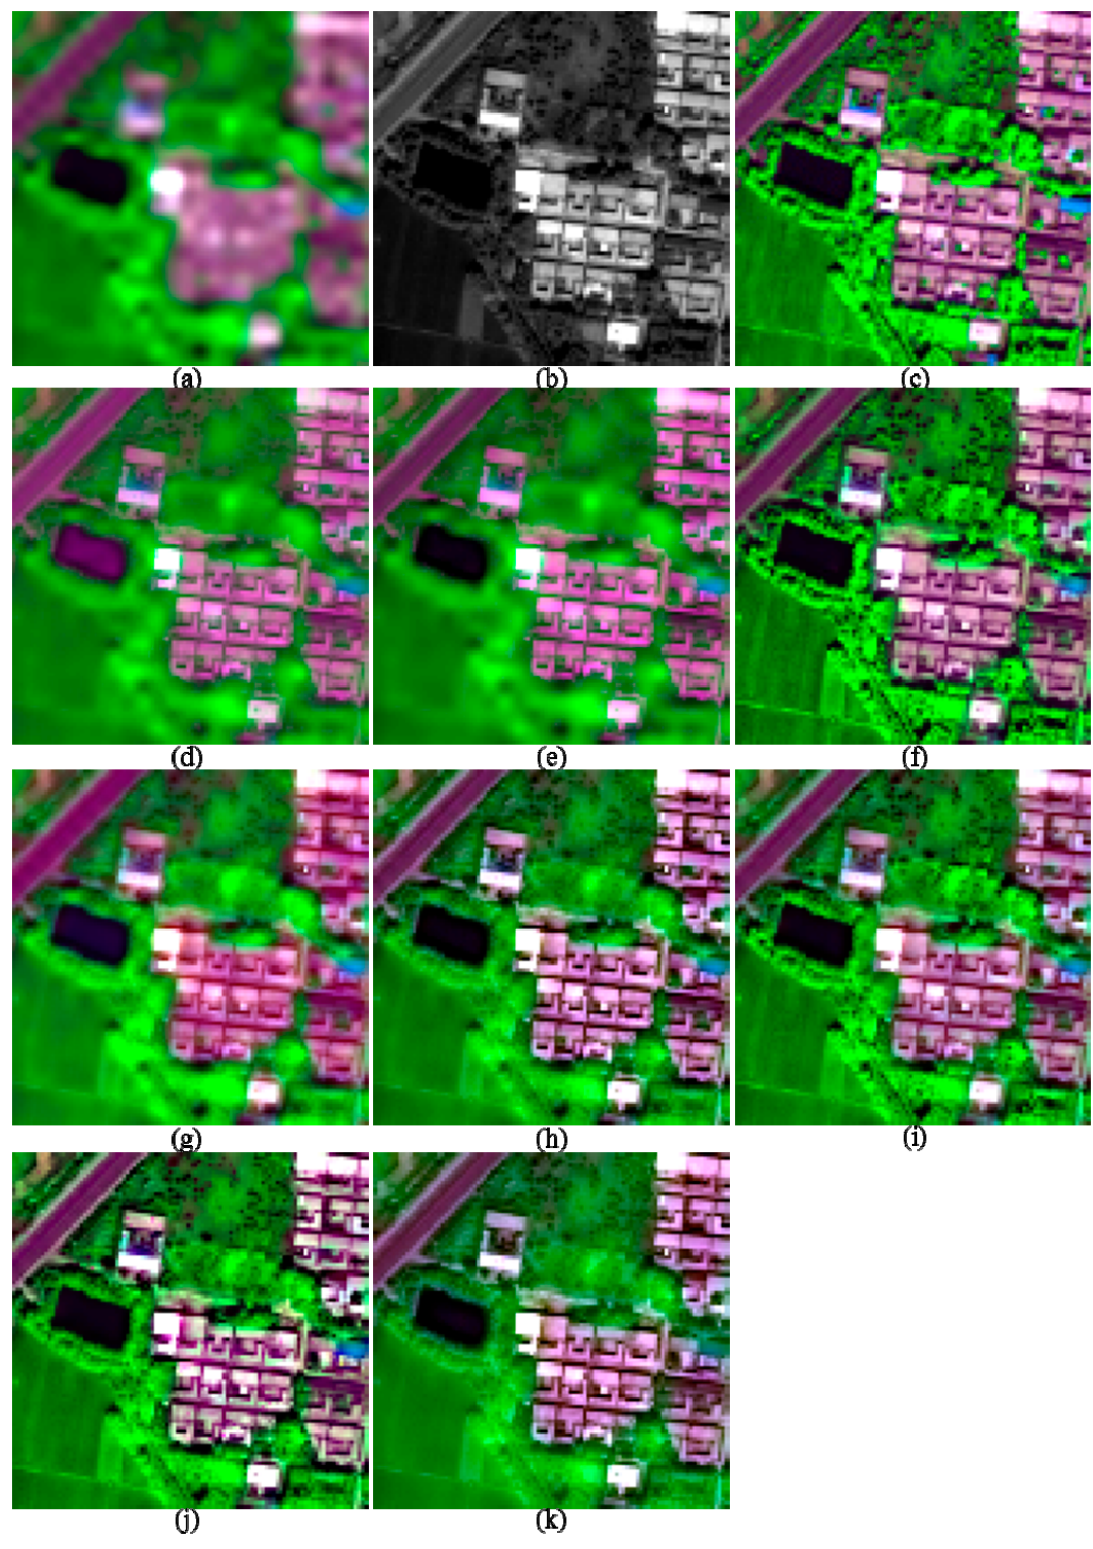
Figure 7. The original and 2-m fused images of I5, shown in band 5-7-2 composition. ( a ) 8-m MS; ( b ) 2-m PAN; ( c ) True 2-m MS; ( d ) GS; ( e ) GSA; ( f ) HR; ( g ) HCS; ( h ) ATWT; ( i ) GLP_ESDM; ( j ) GLP_ECBD; and ( k ) NSCT_M2.